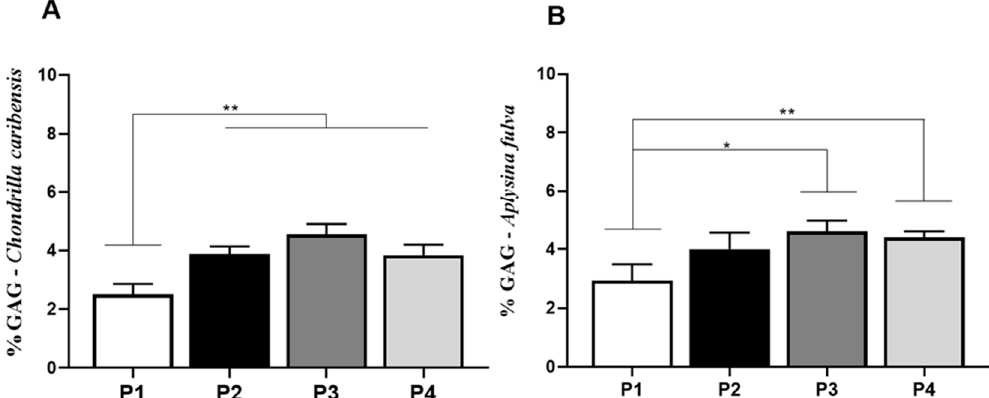
Figure 8. Percentage of GAG per extract obtained for the species C. caribensis and A. fulva . ( A ) C. caribensis extraction protocols P1, P2, P3, and P4, statistical differences were found between groups P1 vs. P2, P3 and P4 ** ( p < 0.01). ( B ) For A. fulva specie for extraction protocols P1, P2, P3, and P4, statistical differences were found between groups P1 vs. P3, * ( p = 0.0075) and P1 vs. P4 ** ( p = 0.0154). All analyses were performed in triplicate (Anova/Tukey test).